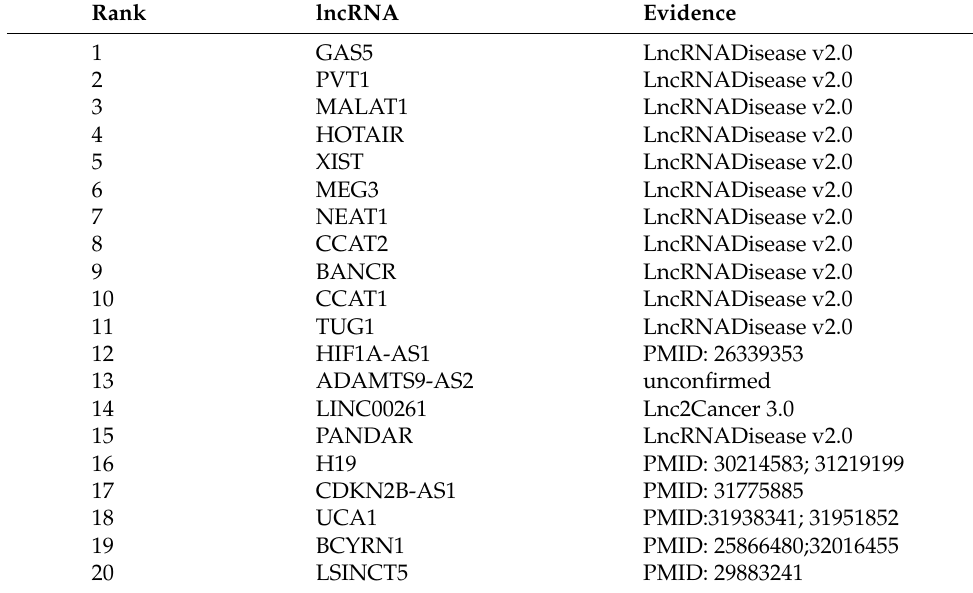
Table 4. Top 20 identified lncRNAs for non-small cell lung